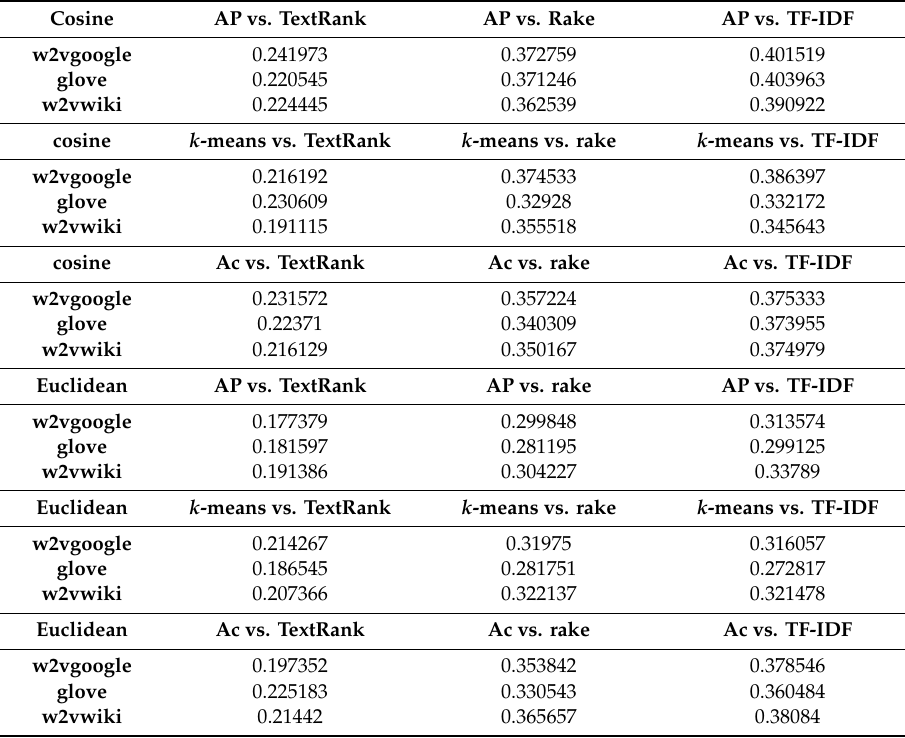
Table A4. SD coe ffi cients for baseline approaches and our method, on n gram.